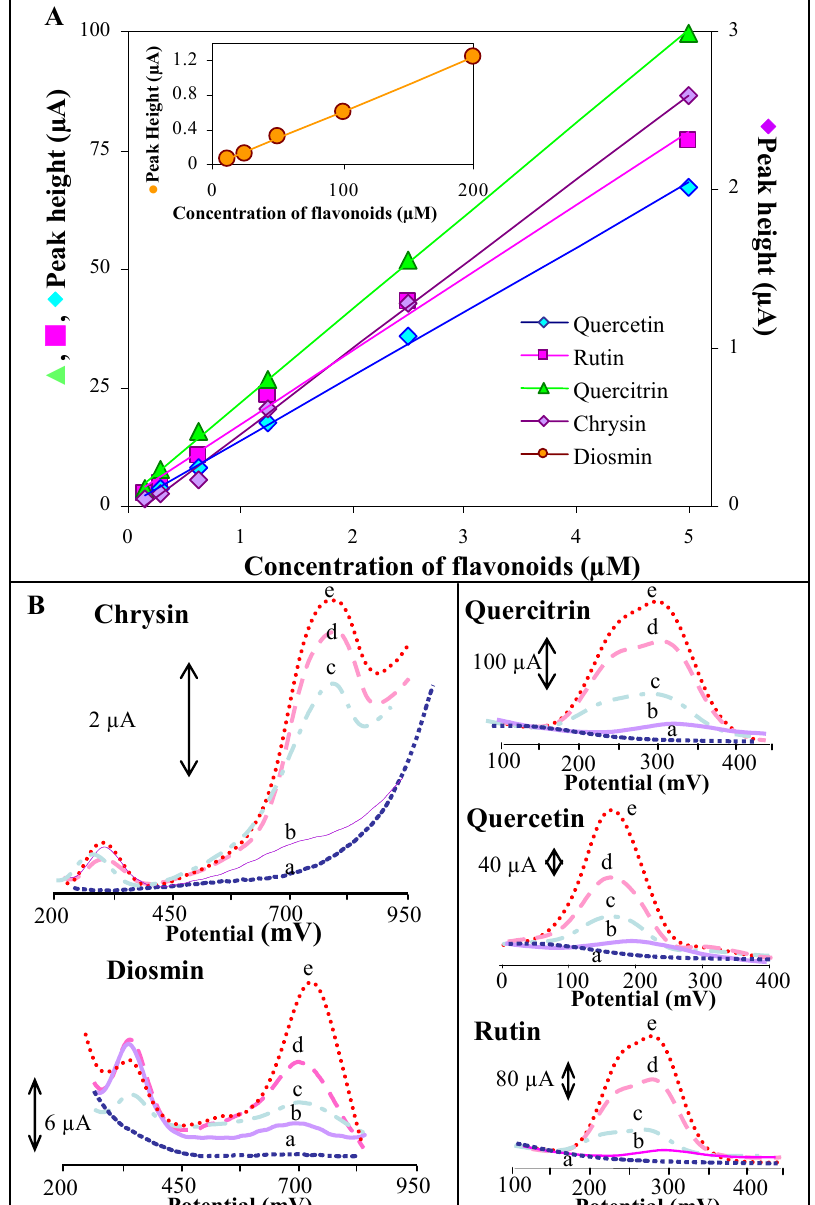
Figure 5. Dependencies of peak heights of the flavonoids on their different concentrations ( A ). Influence of human urine on signals of the flavonoids ( B ): a) electrolyte; b) 1,000 times dilute solution of human urine; c) 5 µM of the flavonoids except diosmin 300 µM; d) 7.5 µM (400 µM); e) 10 µM (500 µM). For other details see Figure